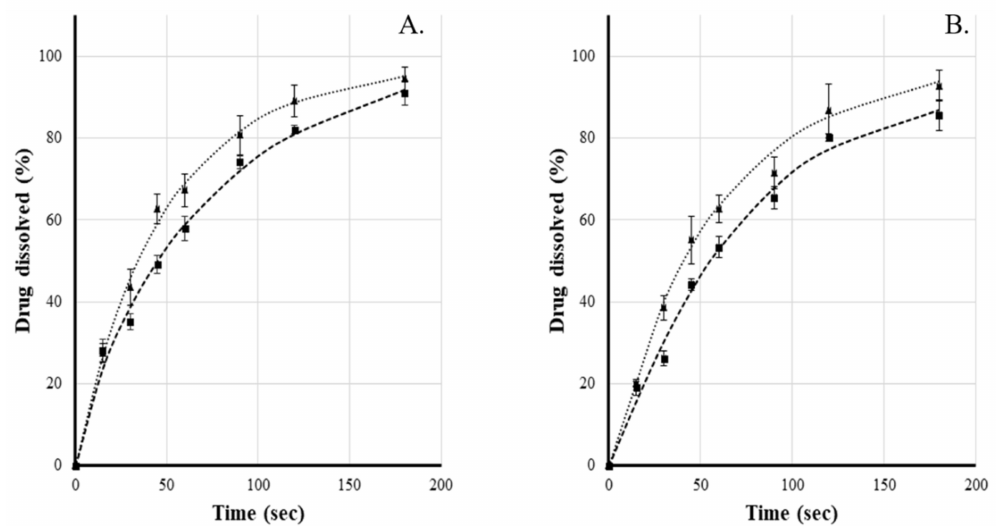
Figure 5. Indigo carmine ( A ) and β -galactosidase ( B ) release profile of straw containing matrix ( (cid:4) ) and layered pellets ( (cid:78) ). T = 20 ◦ C; 40